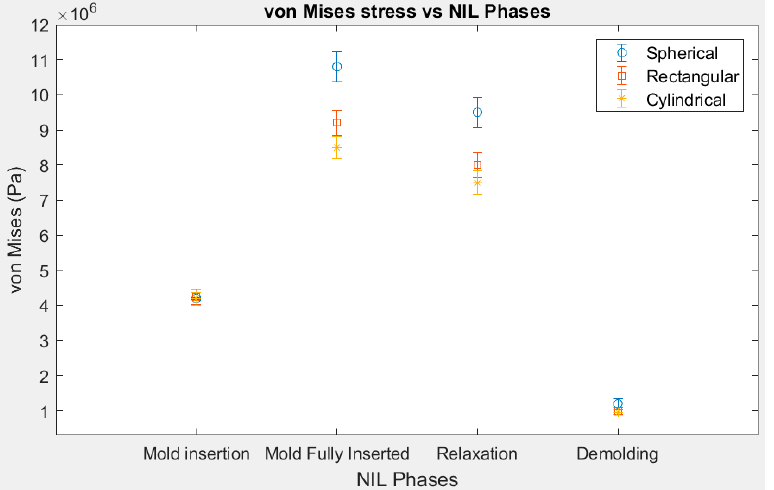
Figure 3. von Mises stresses at various NIL phases for different mold profiles. The time steps are initial mold insertion—20,000; mold fully inserted—58,000; relaxation—50,000; demolding—160,000.